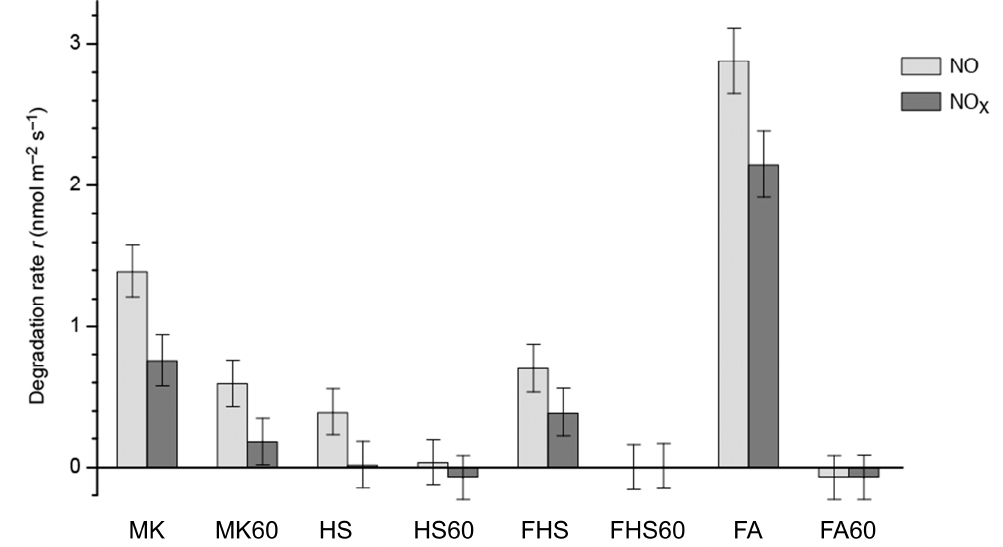
Figure 3. NO and NO x degradation rate r for the alkali activated material (AAM) photocatalytic samples. Measures carried out at 75 ppb NO concentration and 400 ± 10 μ W·cm − 2 UV-A irradiance. Bars are 1 σ repeatability errors.